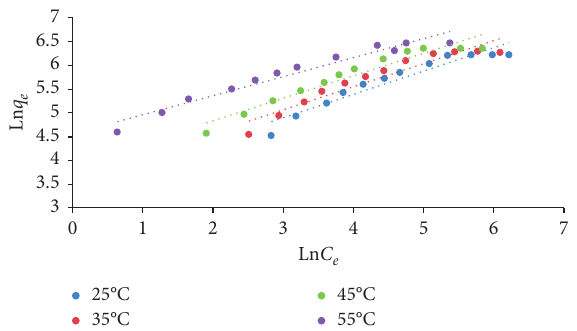
Figure 9: Freundlich isotherm for MnO ZCOBLP.